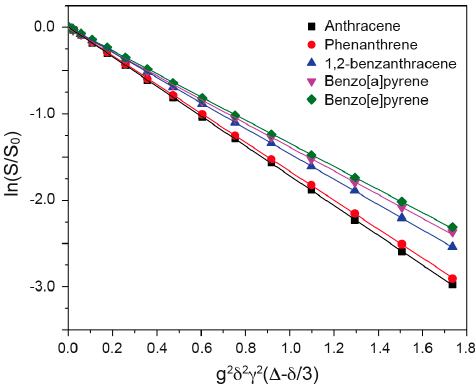
Figure 5. Stejskal-Tanner plot for each species in Mixture C. Table 2. Summary of diffusion coefficients of compounds in different mixture solutions.